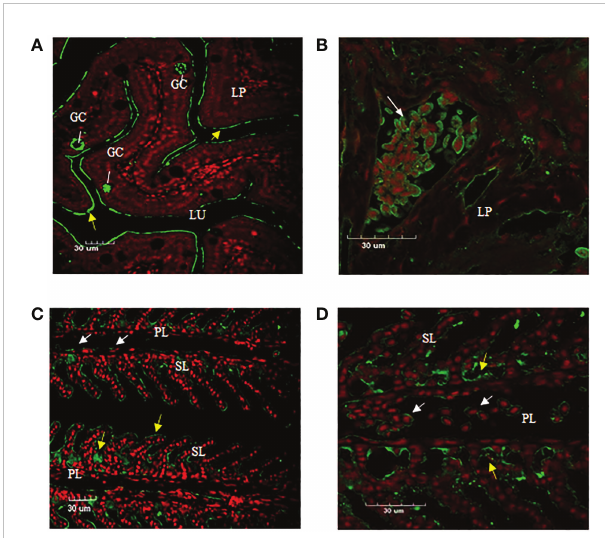
FIGURE 5 Immuno fl uorescence staining of IgT-expressing cells in gill and intestine of ASB. Gill and intestinal tissue samples were embedded in paraf fi n and sectioned. Immunohistochemical staining was carried out using mouse anti-CH2-CH4 IgT antibody followed by rabbit anti- mouse FITC. (A) Presence of goblet cells (GC) secreting mucus in the lamina propria (LP) and plausibly secreted IgT (yellow arrows) lining the mucosal surface of the intestine. (B) Enlarged image of IgT+ cells presented in the lamina propria (LP) of the intestine (white arrow). (C) Localization of IgT+ cells (white arrows) in the primary lamellae (PL) and possibly secreted IgT (yellow arrows) coating the surface of secondary lamellae (SL) in the gill of ASB. (D) Magni fi ed image of IgT+ cells located in primary lamellae of ASB gill (white arrows). ASB intestine and gill were stained with mouse anti-IgT (green) and propidium iodide (red). Images are representative of at least three independent experiments.